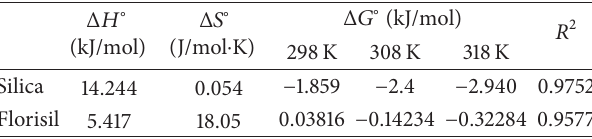
Figure 10: Adsorption isotherm of As(V) onto impregnated silica and florisil. Table 3: Thermodynamic parameters.